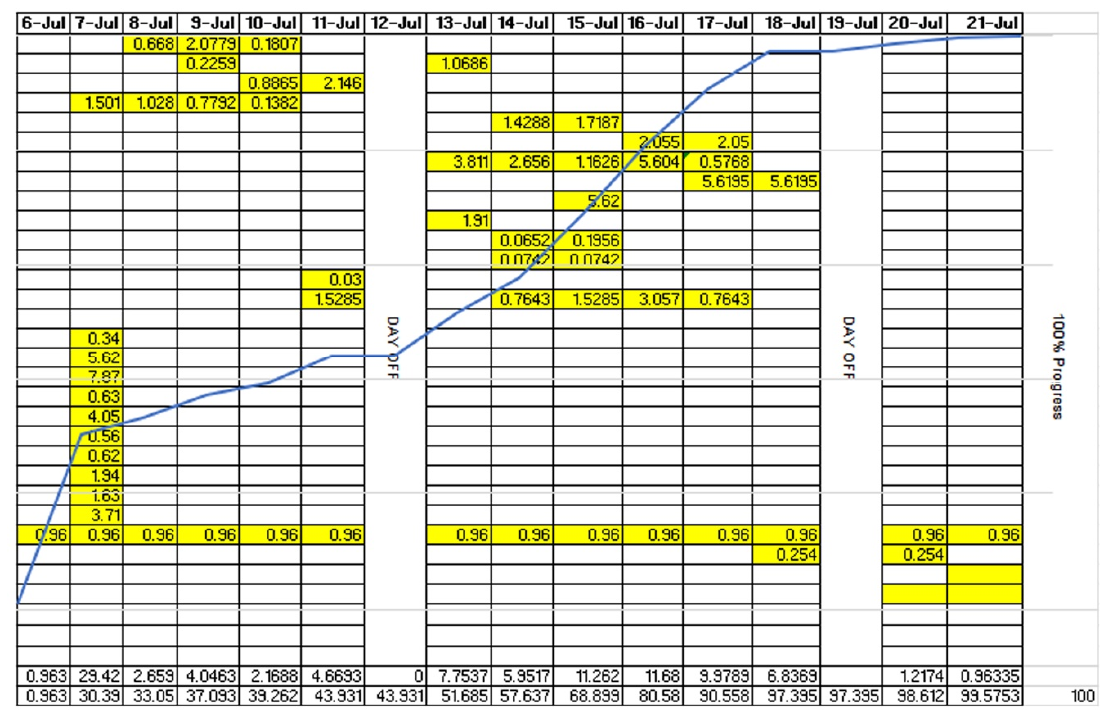
Figure 4. S-curve for building construction process.